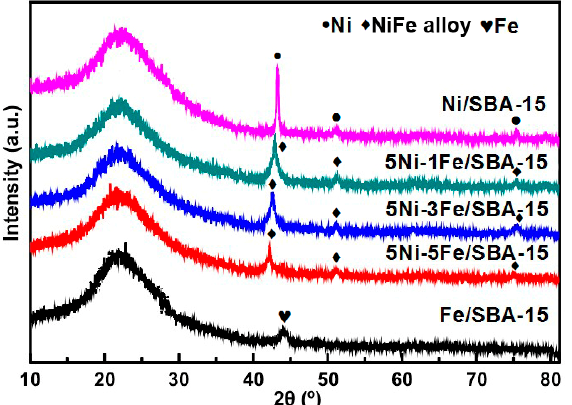
Figure 1. XRD (X-ray powder diffraction) patterns of the Ni/SBA-15, 5Ni-1Fe/SBA-15, 5Ni-3Fe/SBA-15, 5Ni-5Fe/SBA-15, and Fe/SBA-15 catalysts.